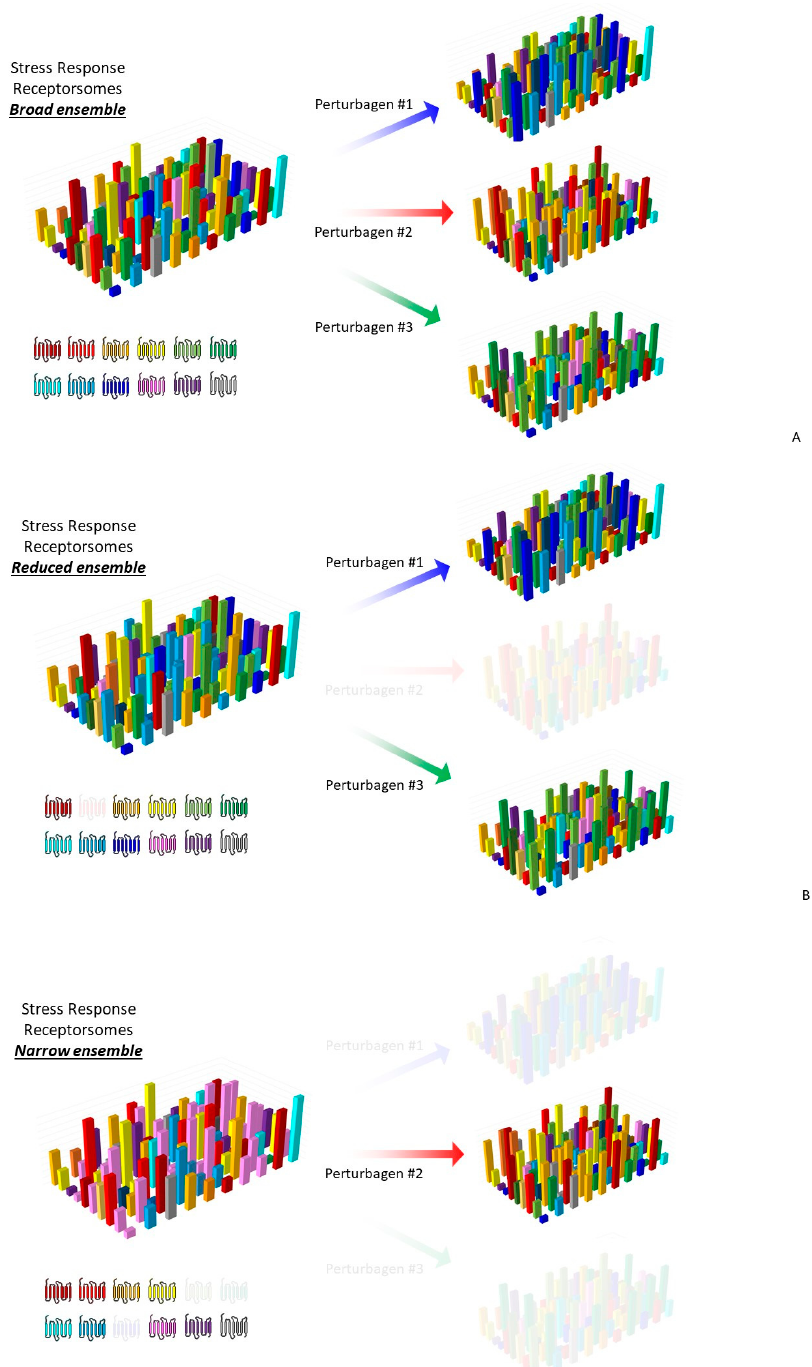
Figure 2. Stress response receptorsome ensemble breadth controls the cellular resilience. For each of the figure panels, a given receptorsome type is denoted by its specific color, while the vertical height of the receptorsome block represents its numerical representation in the total cellular complement of the intracellular GPCR structures. ( A ) Given a cellular scenario in which a broad variety of stress-responsive receptorsomes are present, it is likely that the dynamic responses (to distinct perturbagens 1–3), indicated by a specific elevation of the numbers of the specific sensitive receptorsome types (perturbagen 1—blue, perturbagen 2—red and perturbagen 3—green), can attenuate the damage to all three stress types. ( B ) With a reduced number of available receptorsomes (loss of red), the cell is unable to mount an effective response to one of the perturbagens (#2—red), thus resulting in an augmented level of experienced damage. ( C ) With a narrow range of receptorsomes maintained by the cell (loss of blue and green), it can only adequately contend with one stressor perturbagen (#2—red), while significant cellular damage may occur, as the majority of stressor per- turbagens cannot be mitigated.